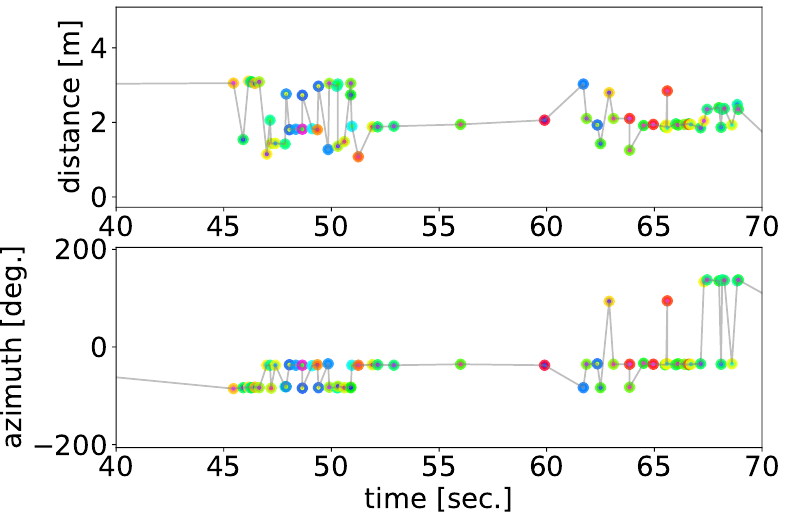
Figure 9. Detailed results of that shown in Figure 8 during 40–70 s. Multiple individuals sang alternately at some directions. The dot colors correspond to the colors given in Figure